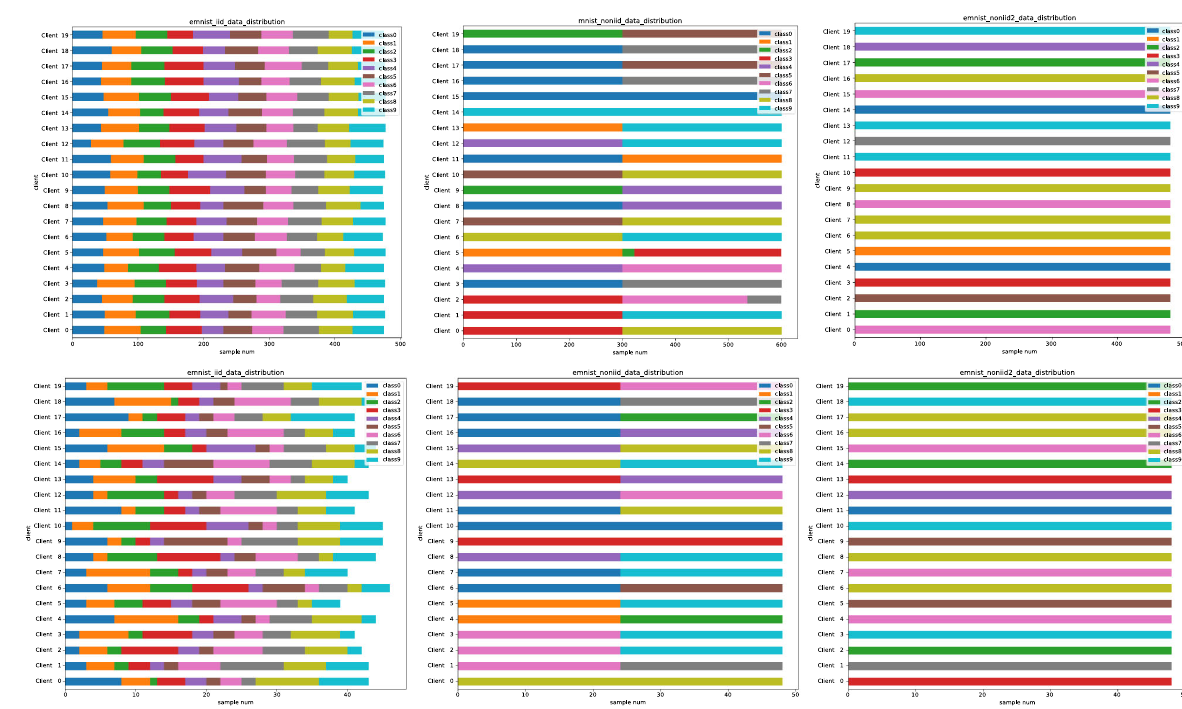
Fig. 7 Data distribution of the top 20 clients in the EMNIST-L dataset (moderate device number is above, massive device number is